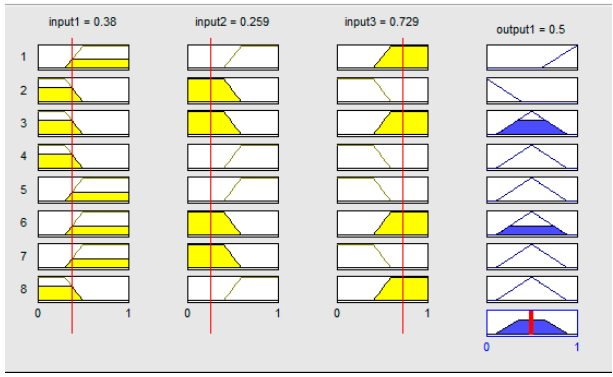
Figure 11. An example of using fuzzy rules to combine sensors input.